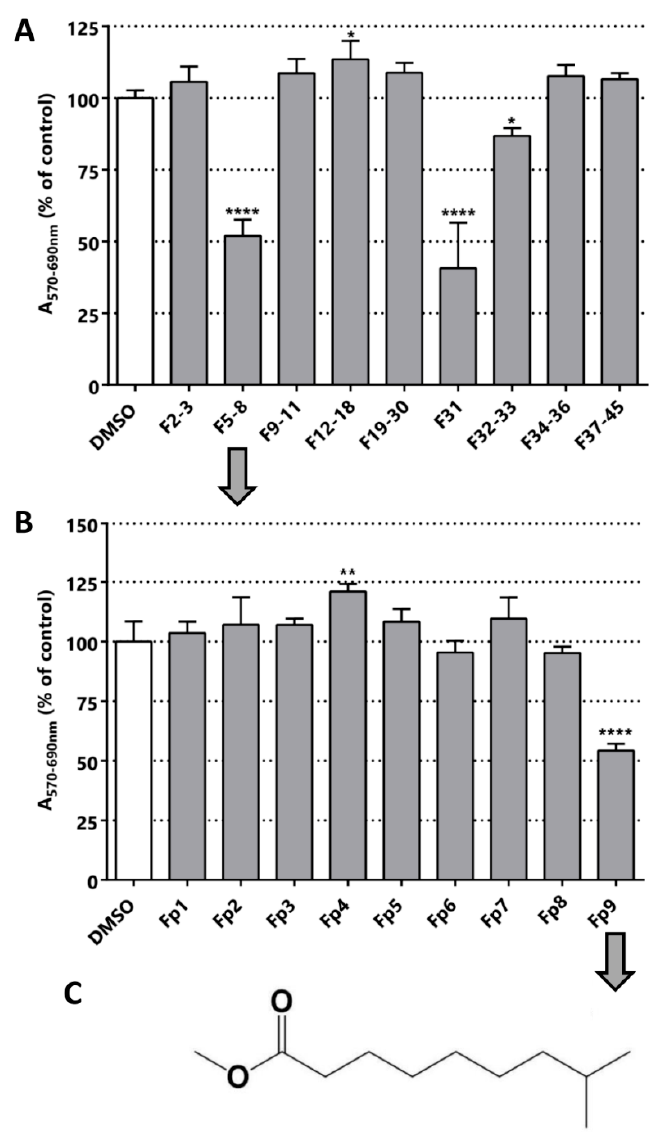
Figure 4. Bioguided fractionation. Cytotoxic/anti-proliferative activity of the C. chayamansa extracts (25 µ g/mL) in LNCaP cells. ( A ) Evaluation of the fractions obtained from the silica chromatography of the methanolic extract of C. chayamansa . ( B ) Evaluation of the fractionations obtained by preparative chromatography of F5-8. ( C ) The structure of the compound identified in fraction Fp9: methyl ester of the fatty acid 8-methyl-6-nonanoic acid. Statistical significance is * p < 0.05; ** p < 0.01; **** p < 0.0001.